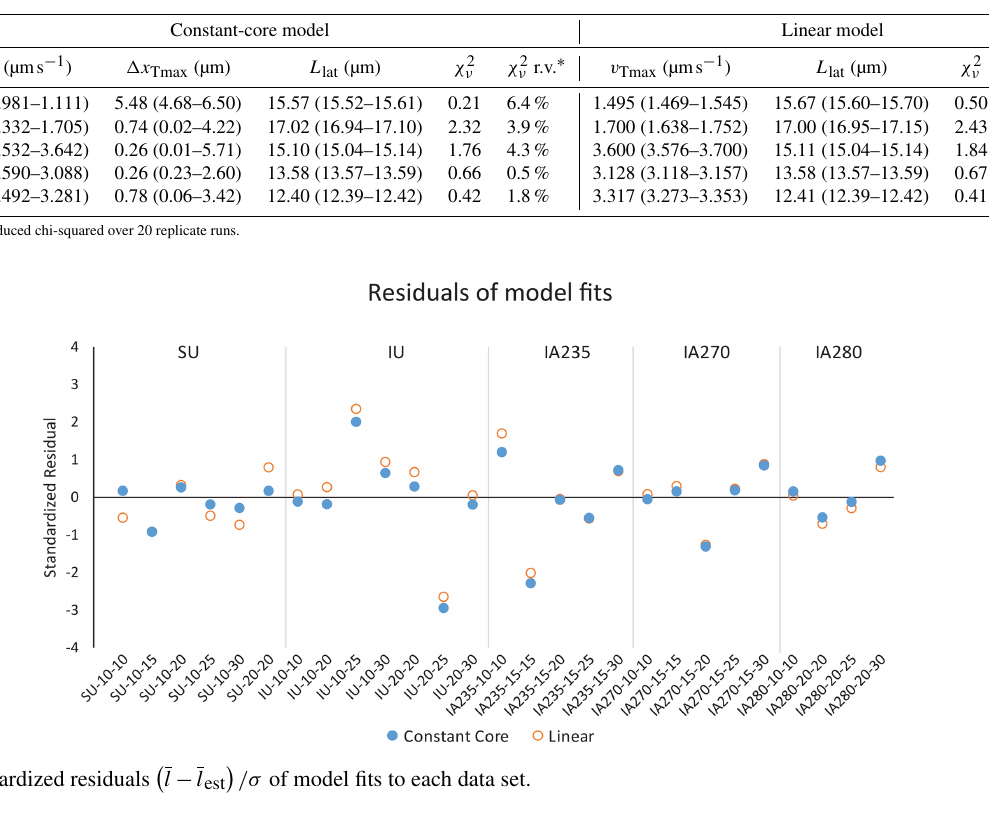
expected observation that annealed tracks (IA235-10,